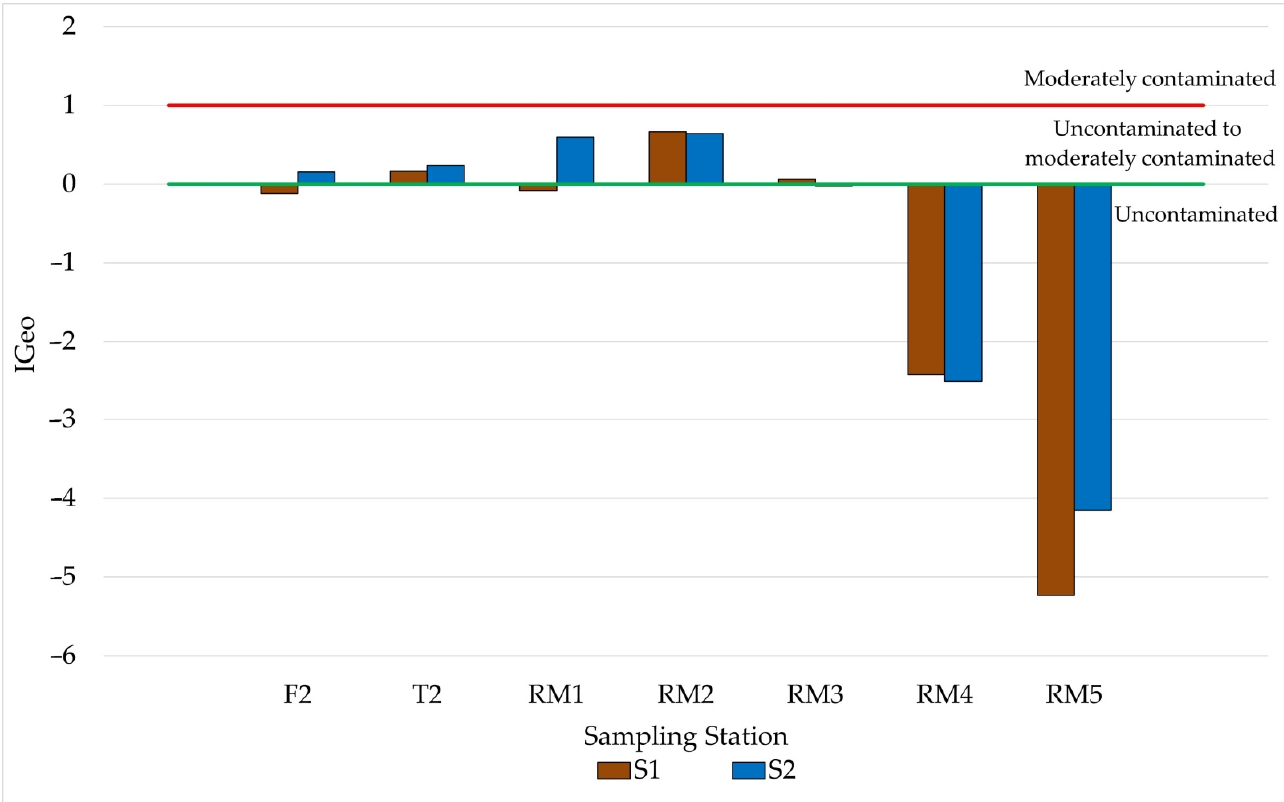
Figure 5. IGeo values in sediment samples collected in the Reis Magos River Hydrographic Basin.